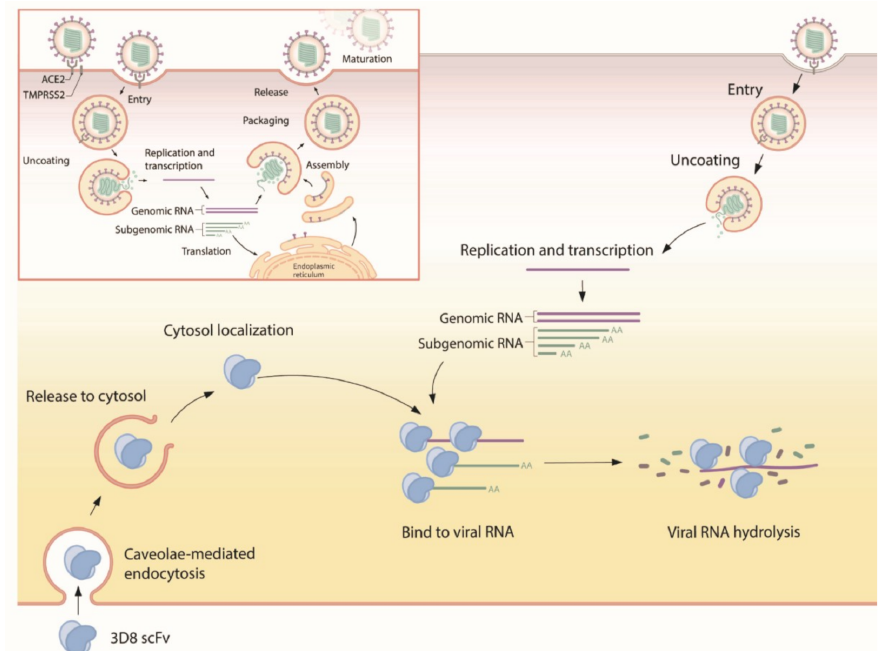
Figure 6. Suggested mode of action for 3D8. First, 3D8 scFv is internalized into the cell through caveolae-mediated endocytosis. After release from the endosomal compartment, 3D8 binds to the viral nucleic acid and degrades it to prevent its amplification, thus inhibiting viral growth. In addition, 3D8 exerts nuclease activity without sequence specificity and hydrolyzes viral RNA genomes or